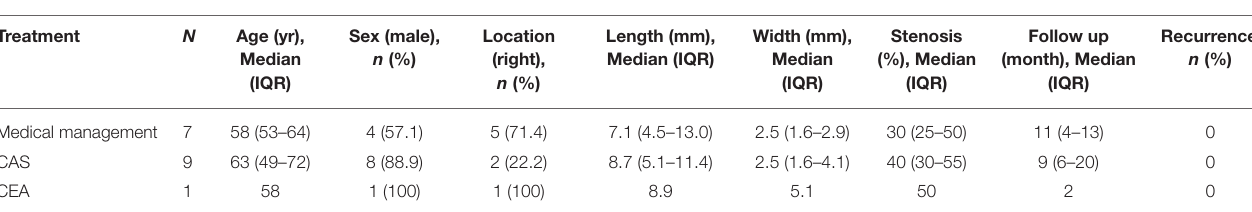
TABLE 3 | Treatment of patients with